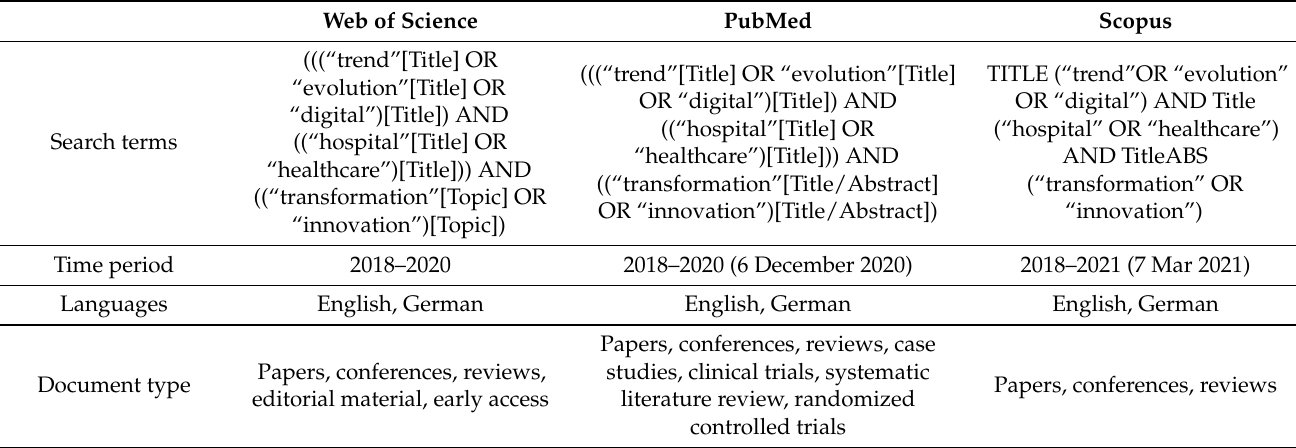
Table 4. The strategy of database searches.